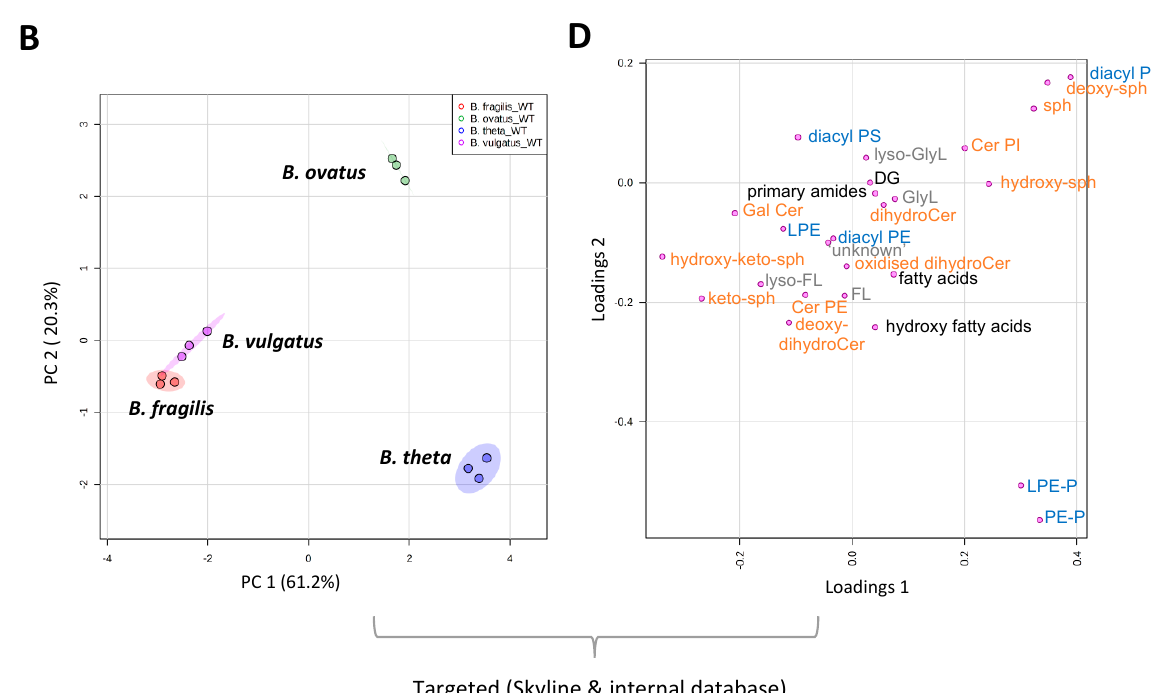
Figure 1. LC-MS and multivariate analysis suggest that B. fragilis and B. vulgatus may have similar lipidomes, which are distinct from both B. thetaiotaomicron and B. ovatus . ( A ) PCA score plot generated from untargeted lipid analysis from both positive or negative mode ionisation data; LC-MS raw data was imported into Progenesis QI, data were median-normalised and log-transformed using MetaboAnalyst 5.0, a web-based platform, prior to multivariate analysis. ( B ) PCA score plot generated from targeted lipid analysis; LC-MS raw data was uploaded into Skyline and processed against our internal lipid database for both positive and negative ionization modes. A correction factor was applied to negative ionization mode data, to combine it with positive ionization mode data, before normalization to the internal standard. Data were then log-transformed using MetaboAnalyst 5.0 wed-based platform prior to multivariate analysis. PC1 represents the maximum variance direction in the data followed by PC2. PC1 and PC2 allow relative distance visualization of each dataset to each other. ( C ) Relative distribution of fatty acyls (FA), glycerolipids (GL), glycerophosholipids (GP) and sphingolipids (SP) among the four Bacteroides species. Data are represented as the mean ± standard deviation (SD) of three independent biological experiments ( D ) The equivalent Loadings plot of (B) reveals differences in the lipid profile of Bacteroides driven largely by plasmalogens (P), diacyl glycerophosphoinositols (PI) and certain sphingolipids (SP). Other lipid representations include; glyerophosphoserines (PS); glycerophosphoethanolamines (PE); lyso PE (LPE); ceramides (Cer); galactosyl (Gal); sphinganines (sph); glycine lipids (GlyL); flavolipins (FL). Targeted LC-MS–based lipidomics reveal the diversity of lipids present in Bacteroides . In total, we identified 170 individual lipids distributed across 4 lipid categories or 26 lipid ‘subgroups’ (according to convention defined in LIPID MAPS) (Figure 1C). The Bacteroides lipidome is dominated by glycerophospholipids (GP) and sphingolipids (SP), with smaller contributions from fatty acyls (FA) and glycerolipids (GL) (see Figure 1C). Targeted analysis also reveals that the observed differences in the lipid profile between Bacteroides species are largely driven by species-dependent signatures related to the presence of plasmalogens (P), diacyl glycerophosphoinositols (PI) and certain sphingolipids (SP), including dihydroce- ramidephosphoinositol (Cer PI) and α -galactosyl dihydroceramide (GalCer) (Figure 1D). In contrast, fatty acids, hydroxy fatty acids, N -acyl amines, diacylglycerol (DG), glycerophos- phoethanolamine (both diacyl PE and lyso PE (LPE)), diacyl glycerophosphoserine (PS), dihydroceramide (dihydroCer) and dihydroCer phosphoethanolamines (Cer PE)